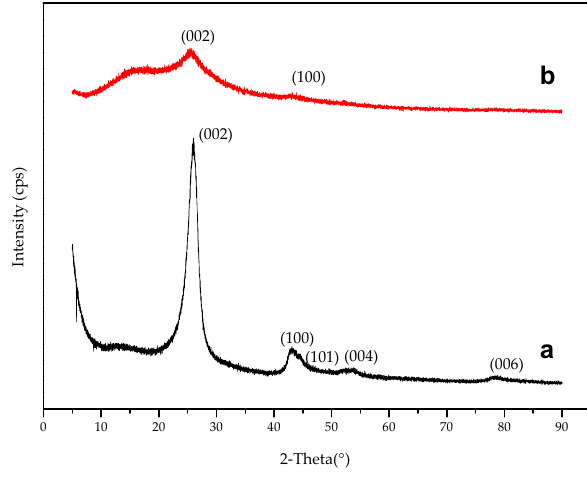
Figure 2. XRD patterns ( a ) Pristine CNT ( b ) Functionalized CNT.